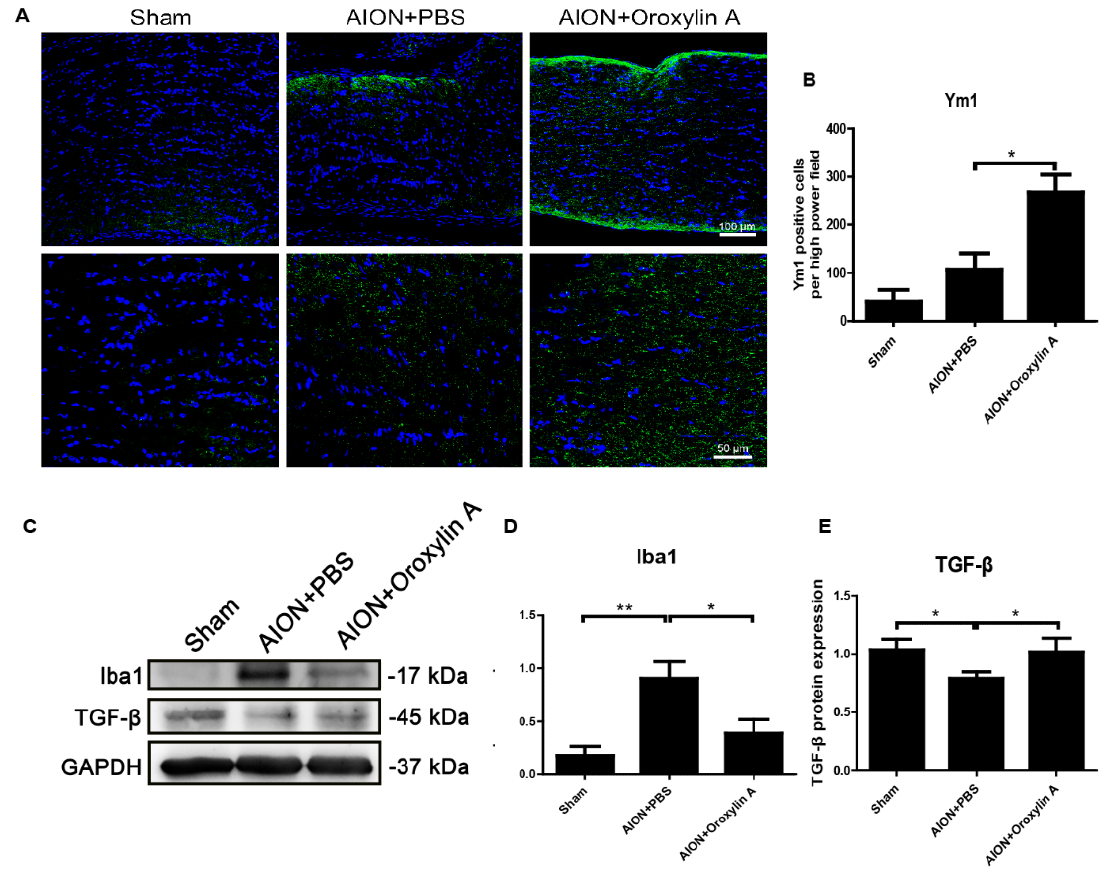
Figure 10. ( A ) IHC of Ym1 in the ONs 28 days after rAION. ( B ) the bar chart indicates that the numbers of Ym1-positive cells (green) per HPF in the sham, PBS-treated, and OA treated-groups were 40.3 ± 24.3, 107. 2 ± 33.5, and 268 ± 36.8, respectively. Scale bar, 50 µ m, N = 6 in each group. ( C ) immunoblotting analysis of the expression levels of Iba1 and TGF β in the ONs after rAION. OA suppressed Iba1 and increased TGF β in the ONs 28 days after rAION. ( D , E ) quantitative analysis of ( C ). Results represent the means ± SDs and are presented as ratios with the GAPDH value for three independent experiments. Scale bar, 100 µ m (upper); 50 µ m (lower); * p ≤ 0.05, ** p ≤ 0.01.